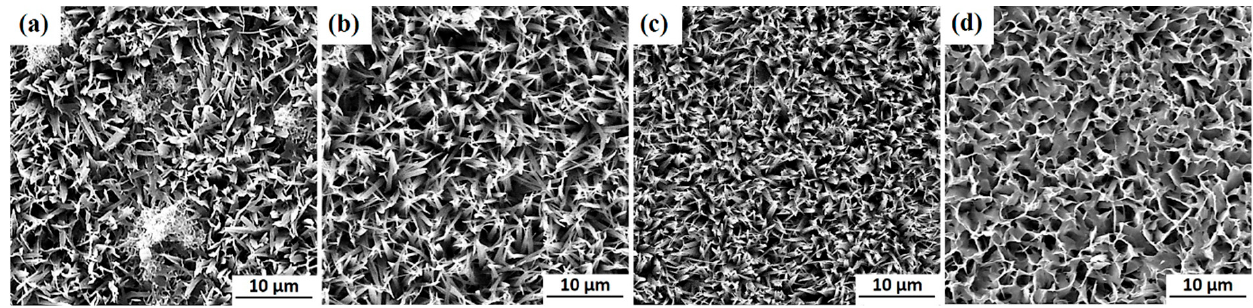
Figure 9. The top-view SEM images of HAp electrodeposited over a range of ultrasonic power: ( a ) 0 W, ( b ) 20 W, ( c ) 60 W, and ( d ) 100 W. Reprinted with permission from [175]. Copyright 2017 Elsevier.